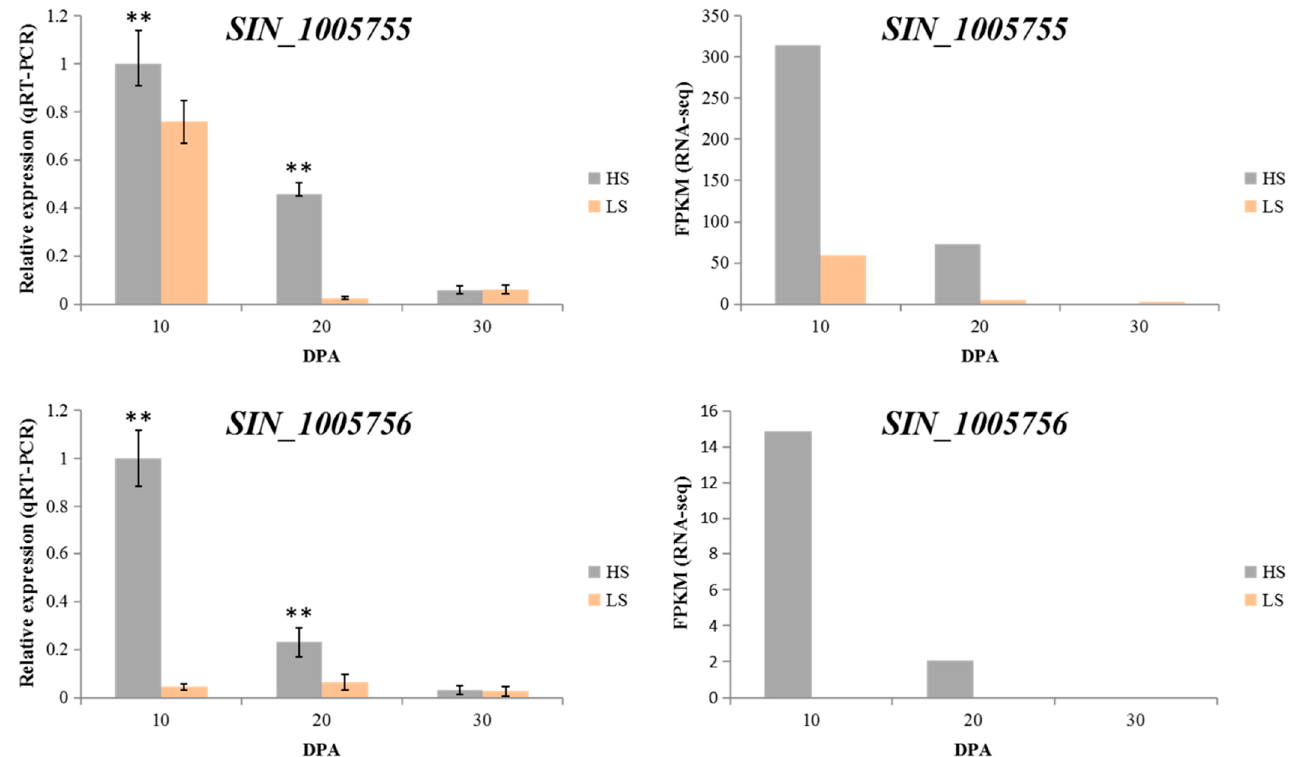
Figure 4. Expression profiles and qRT-PCR validation of the candidate regulatory genes. Note: HS, Zhongzhi No. 13; LS, ZZM2748. ** indicates statistically differences at p < 0.01.